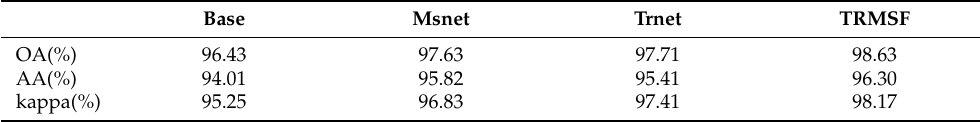
Table 4. Ablation study result on the Trento